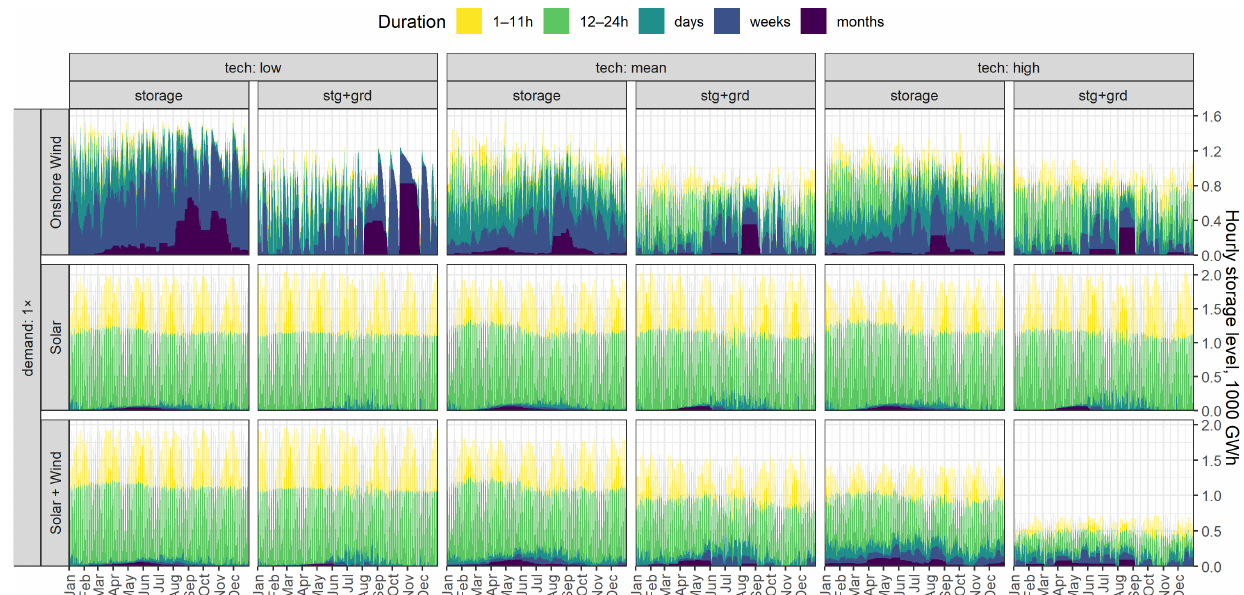
Figure 10. Decomposition of storage level by duration of charge in scenarios without demand response.